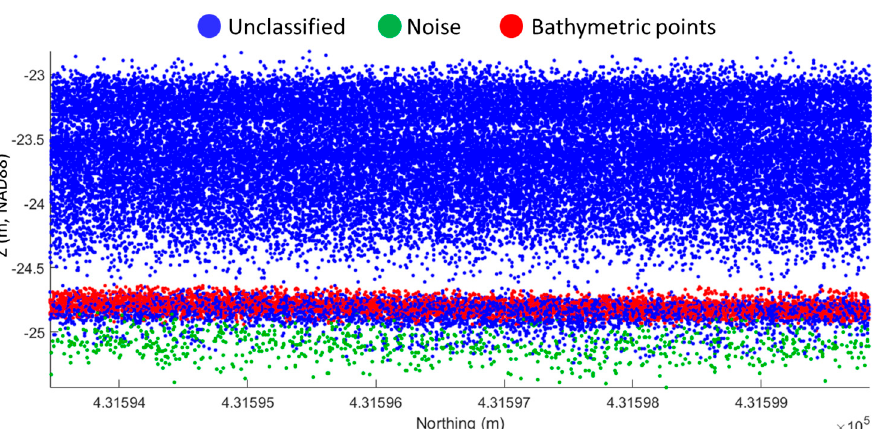
Figure 1. Bathymetric point cloud data acquired in Marco island located in Miami, Florida, USA [11], indicating possible under-segmentation of bathymetric bottom. Note the presence of a gap between the lowest water column points and the bathymetric bottom, which is leveraged in this work.